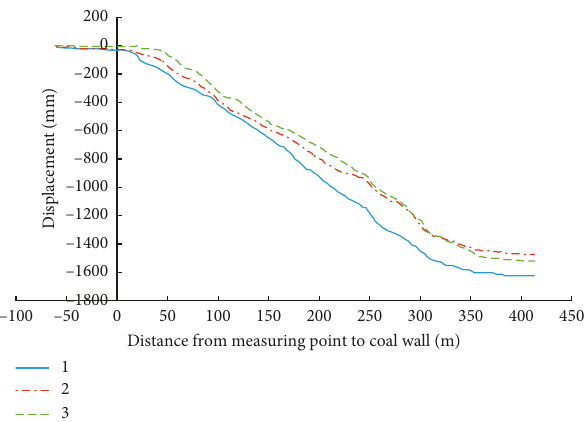
Figure 18: The displacement curves of the overlying strata at the first measuring line.